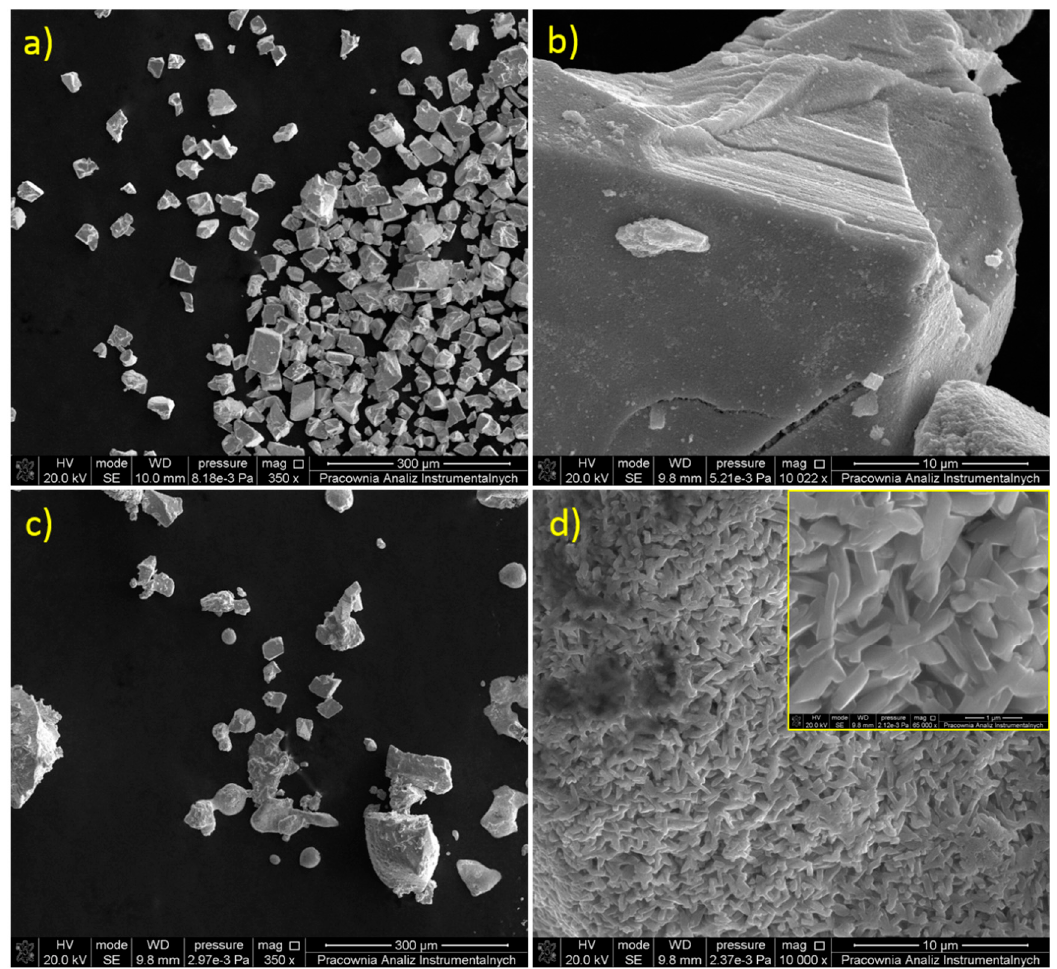
Figure 2. SEM images of ( a , b ) bulk and ( c , d ) hydrated and non-crystalline WO 3 .